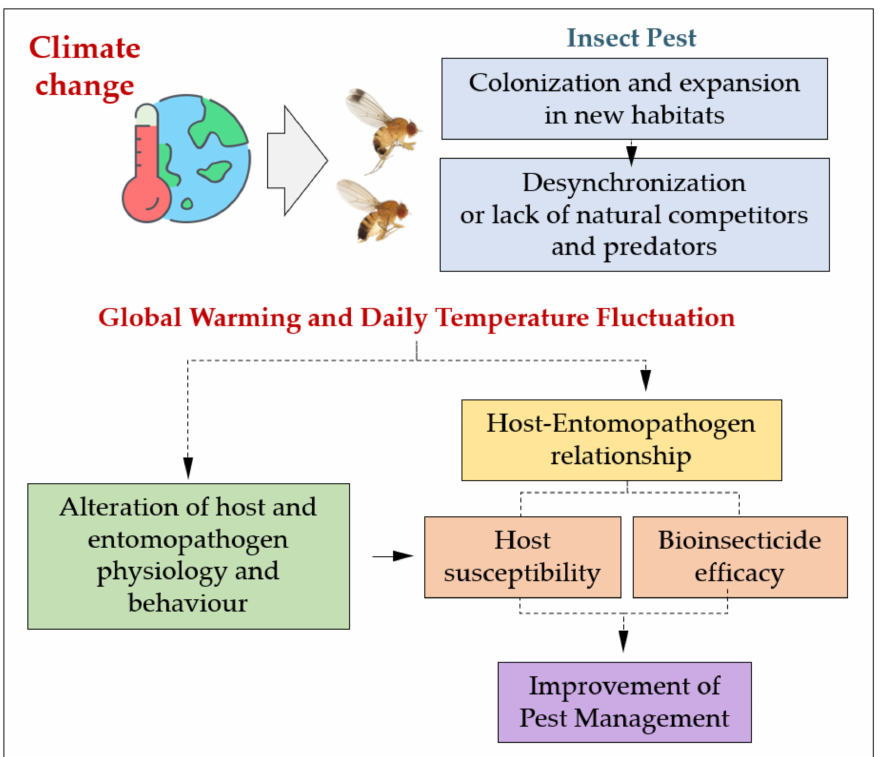
Figure 6. Impact of climate change on pest spread and effects of daily temperature fluctuation and global warming on biological control: pest management could be revised and improved by considering the physiological alterations induced by temperature variations resulting from climate change on bioinsecticides and targets.